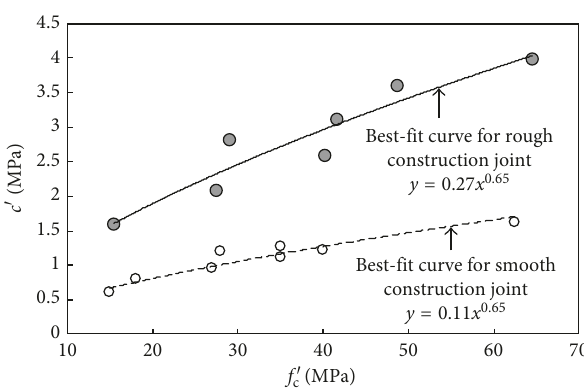
Figure 3: Relationship between c construction